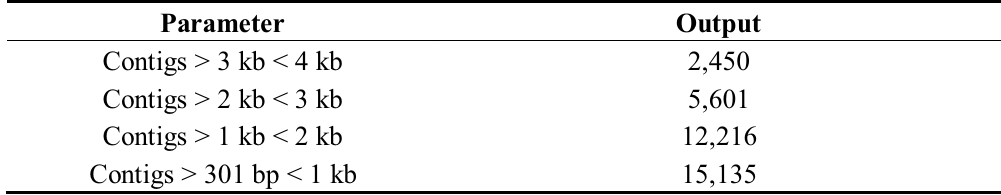
Figure 1. Anasa tristis transcriptome assembly Top BLAST hits across insects and